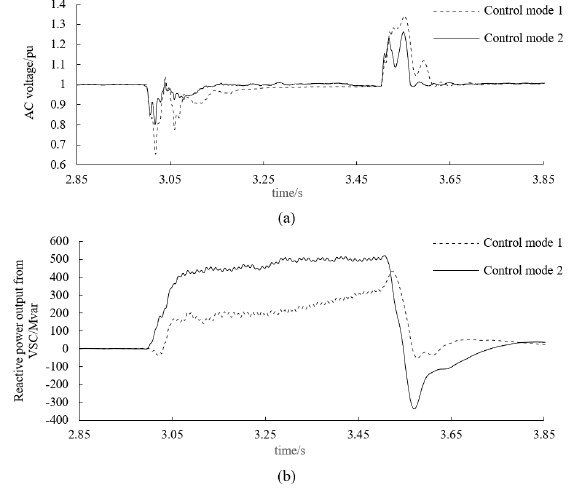
Fig. 11. Simulation comparison diagram of fault lasting for